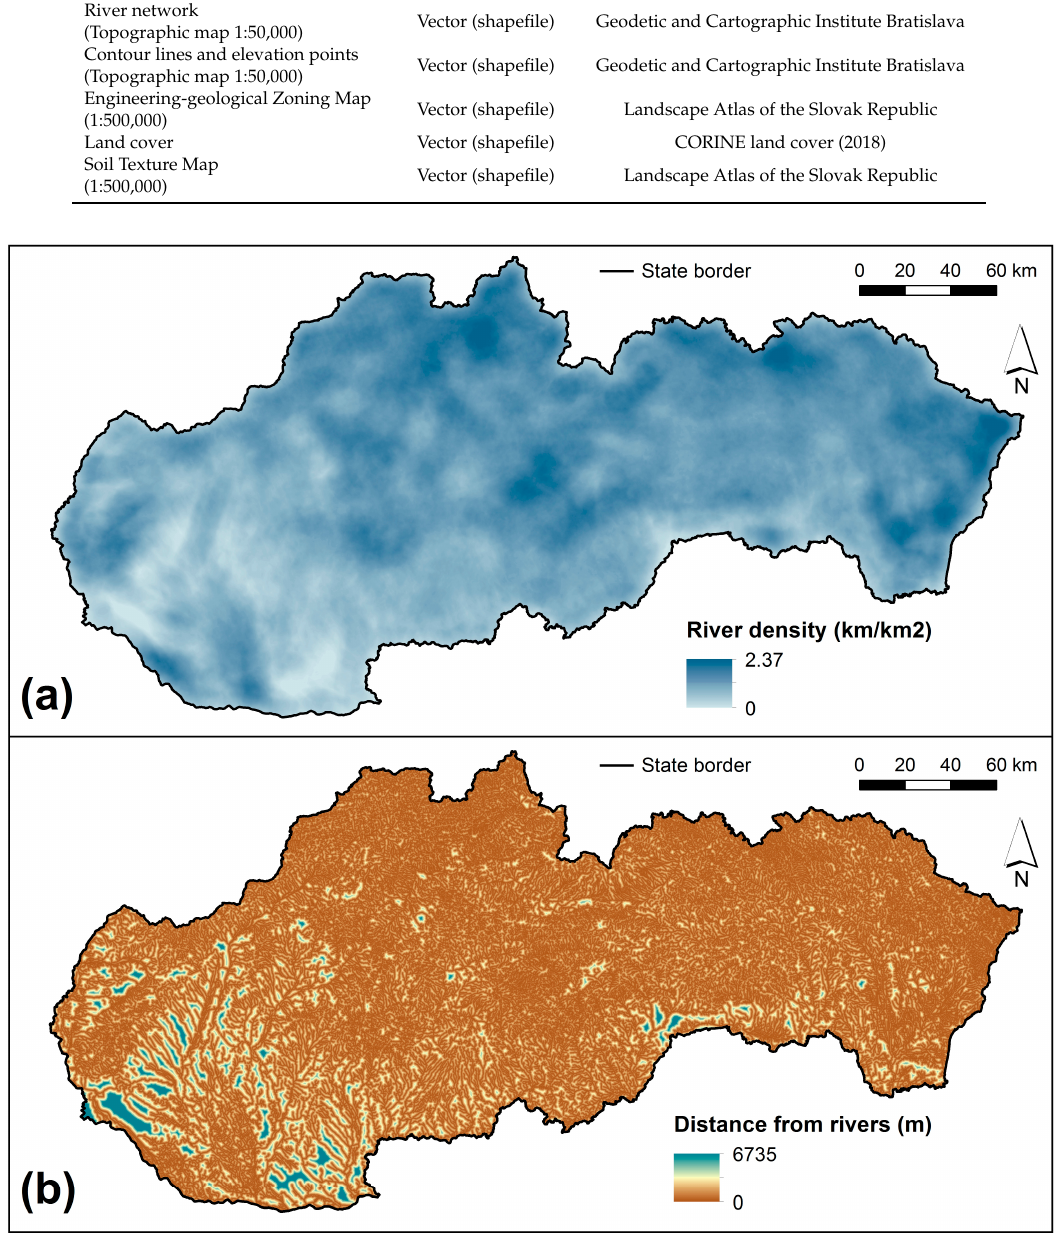
Figure 2. Flood conditioning factors: ( a ) river network density, ( b ) distance from rivers.